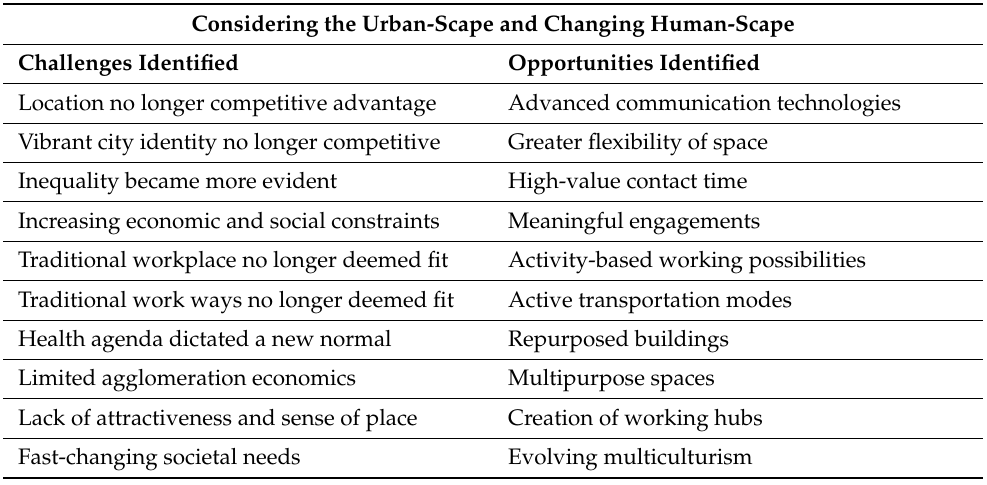
Table 2. Challenges and opportunities identified from the narrative